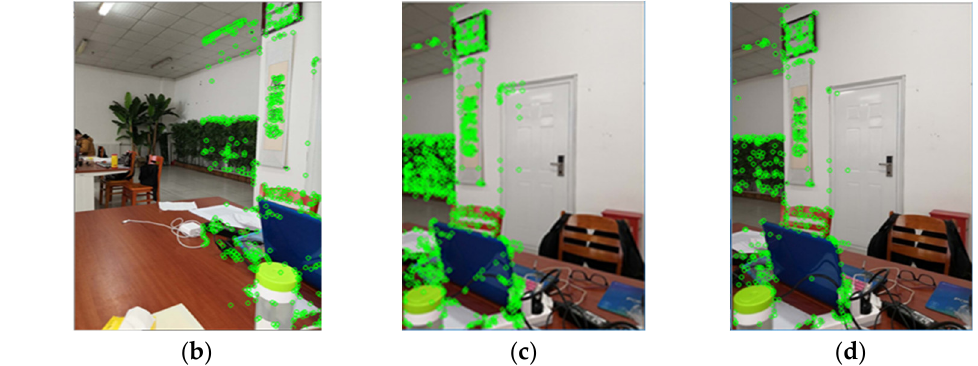
Figure 7. Comparison of the BRISK algorithm before and after gridding: ( a ) non-gridded left view; ( b ) gridded left view; ( c ) non-gridded right view; ( d ) gridded right view. Table 1. The detection results of left and right views before and after gridding. Left View Right View Non-Gridded BRISK Gridded BRISK Non-Gridded BRISK Gridded BRISK Number of feature points 1156 491 1156